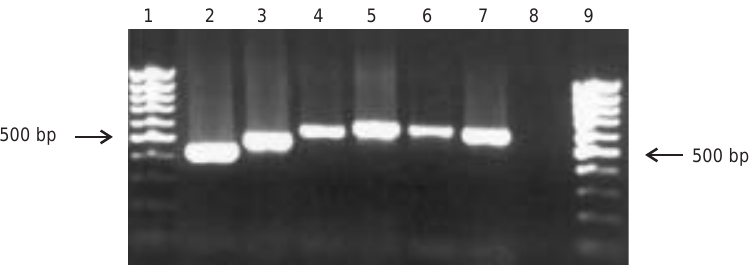
Figure 1. Agarose gel electrophoresis of the PCR as- say performed as positive control to detect 16SrRNA of the searched mycoplasmas in pure culture. Lanes 1 and 9 , size markers DNA-1 kb plus (Invitrogen); lane 2 , Mycoplasma salivarum - 434 bp; lane 3 , Acholeplasma laidlawii - 505 bp; lane 4 , M. arginini - 545 bp; lane 5 , M. fermentans - 579 bp; lane 6 , M. orale - 583 bp; lane 7 , M. hyorhinis - 604 bp; lane 8 , negative